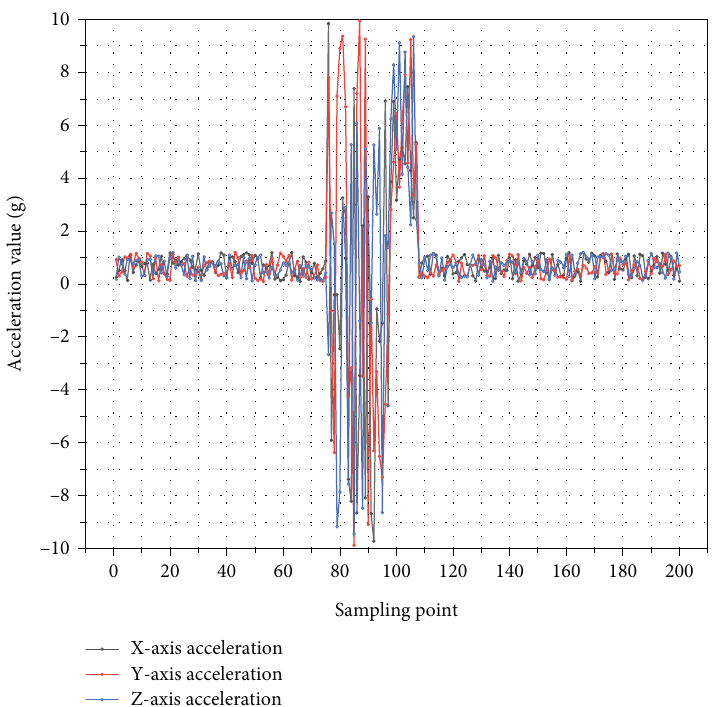
Figure 2: Schematic diagram of acceleration sensor changes for fall-like movements. Table 2: Speech emotion classi fi cation test results. Voice library